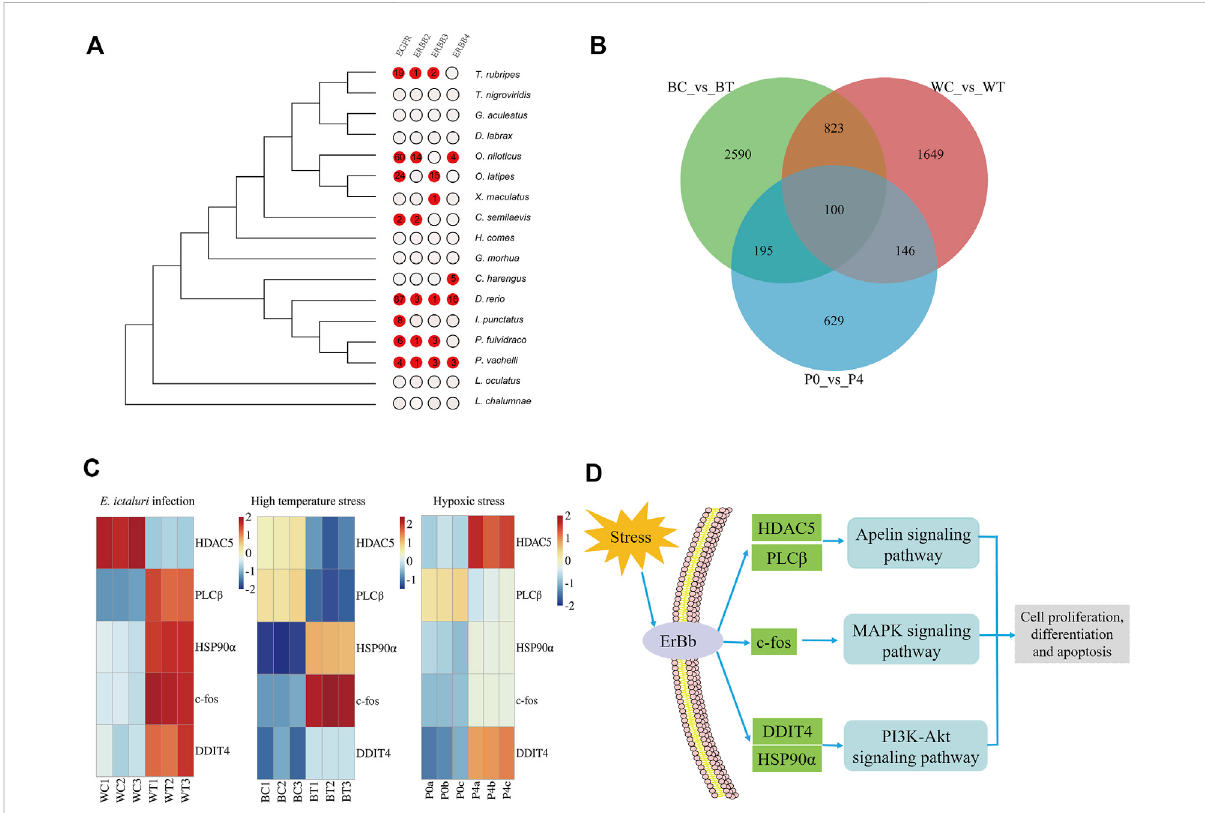
FIGURE 3 Evolutionary analysis of environmental adaptation in P. vachelli . (A) Evolution of the ErbB family in P. vachelli and other fi shes. (B) Veen diagram of signi fi cantly differentially expressed genes in all transcriptomes. BC vs. BT represent control vs. treatment groups in E. ictaluri infection transcriptome, WCvs.WTrepresentcontrolvs.treatment groupsinhightemperaturestresstranscriptome, P0vs.P4representcontrolvs.treatment groups in hypoxic stress transcriptome. (C) Transcriptome expression of candidate genes for environmental adaptation evolution in P. vachelli . Color gradients represent gene expression level of control group and treatment group. (D) Candidate genes and pathways for environmental adaptation evolution in P.